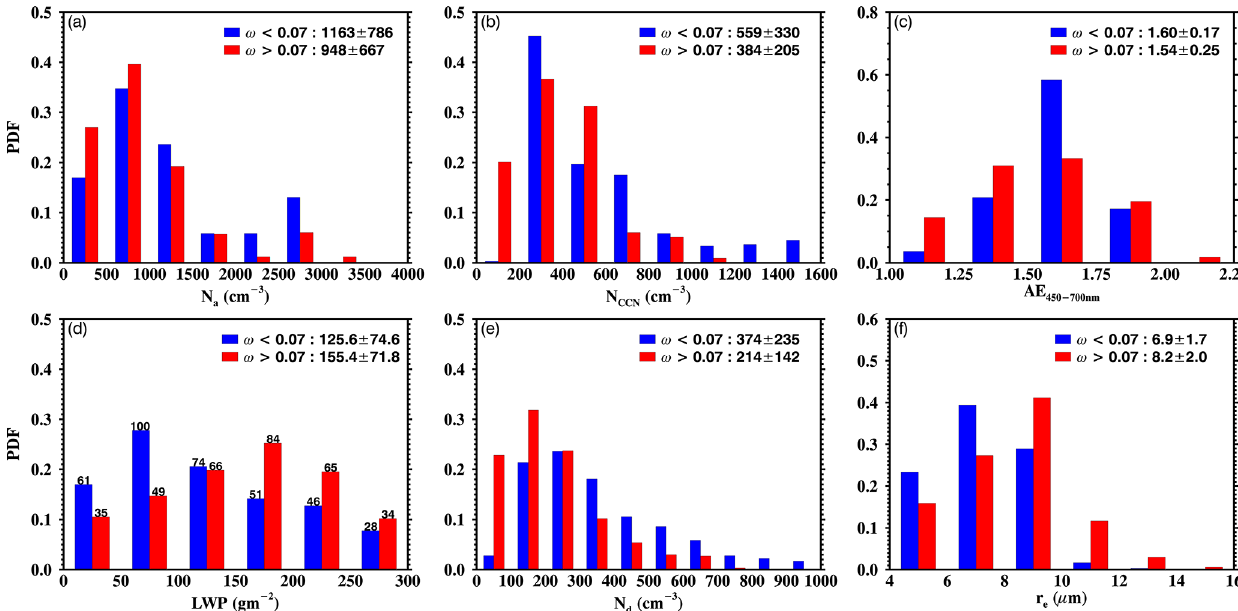
Figure 5. Aerosol and cloud properties under the strongly absorptive (in red) and the weakly absorptive (in blue) aerosol regimes. PDFs, mean values, and standard deviations of (a) N a , (b) N CCN , (c) AE 450 − 700nm , (d) LWP, (e) N d , and (f) r e .